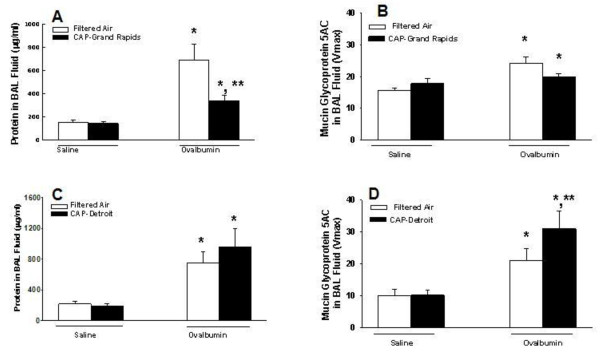
Effect of CAPs exposure on mucus hypersecretion and BALF protein. Animals were sensitized and challenged with saline (white bars) or with OVA (black bars) immediately prior to exposure to CAPs in Grand Rapids (A, B), or Detroit (C, D). Twenty four hours after the CAPs exposure bronchoalveolar lavage fluid was collected and content of total protein and mucin glycoprotein 5 AC were determined as described in Methods. * = significantly different from respective group challenged with saline; ** = significantly different from respective group exposed to filtered air; n = 8/group; p < 0.05.